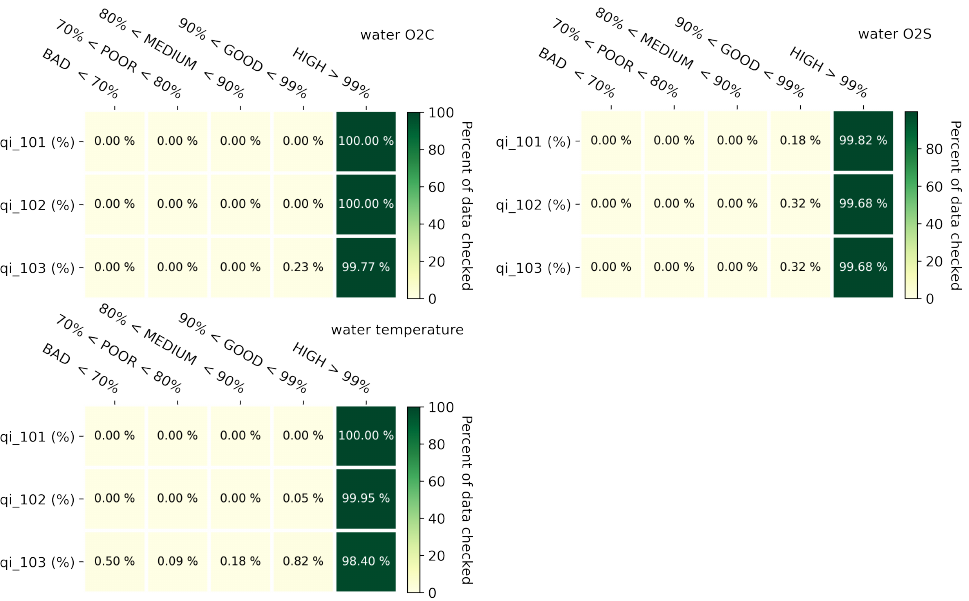
Figure 12. Daily aggregated data quality tests categorized into five FL discrete